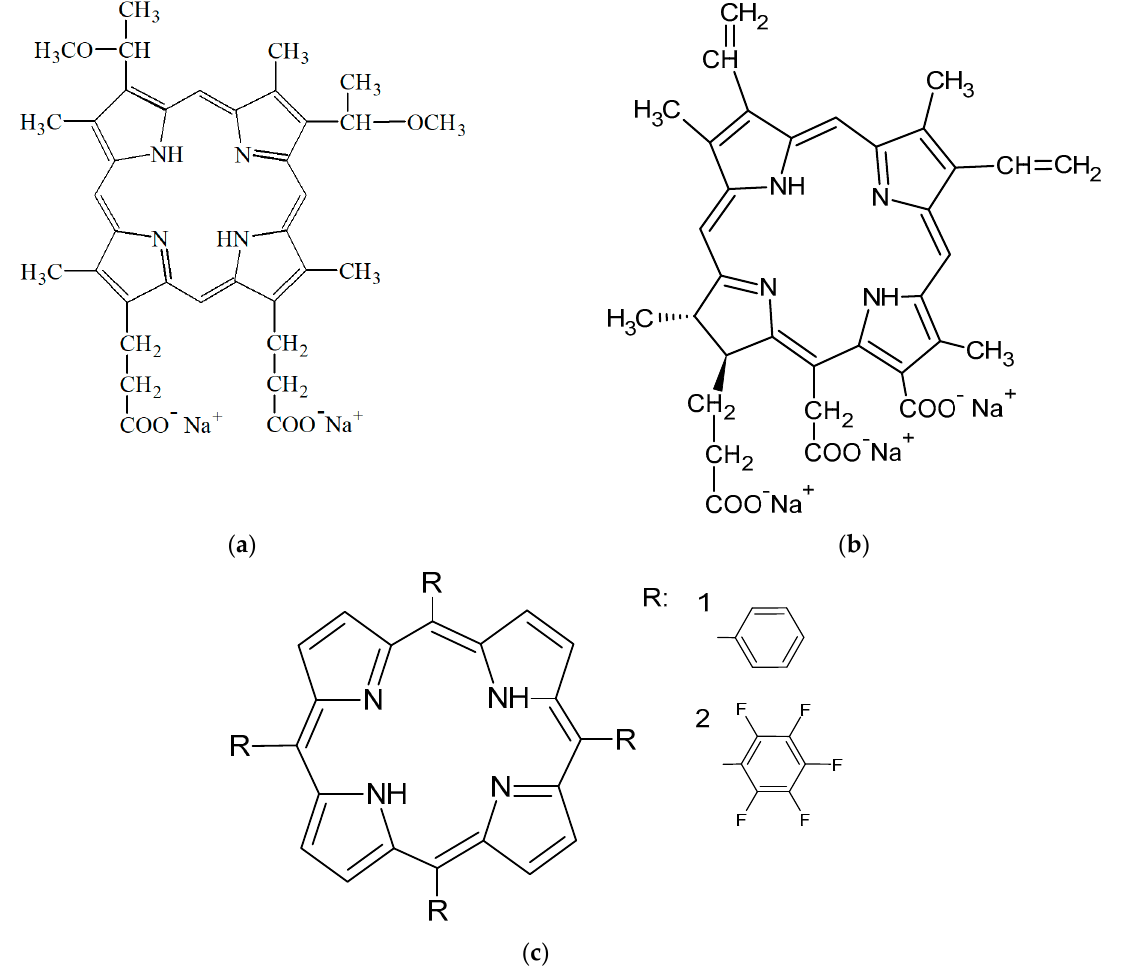
Figure 1. Structural formulas of porphyrins: disodium salt of 3,8-di (1-methoxyethyl) deuteroporphyrin IX ( a ), three sodium salt of chlorin e6 ( b ), 5,10,15,20-tetraphenylporphyrin ( c , 1) fluorinated tetraphenyl porphyrin-5,10,15,20-tetrakis (pentafluorophenyl) porphyrin ( c , 2).